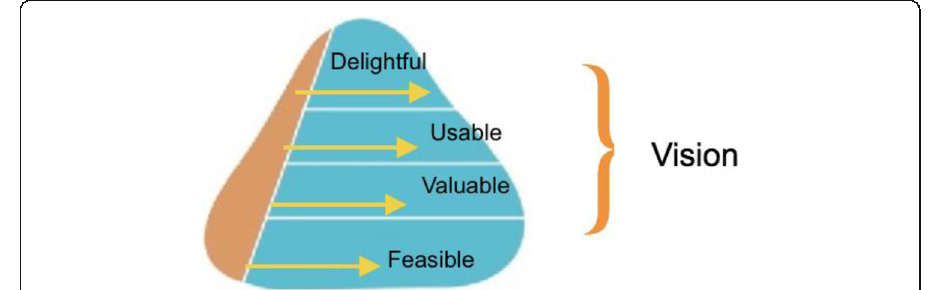
Fig. 6 Minimum viable product, entrepreneurial view for innovation and sustainable competitiveness. © 2016